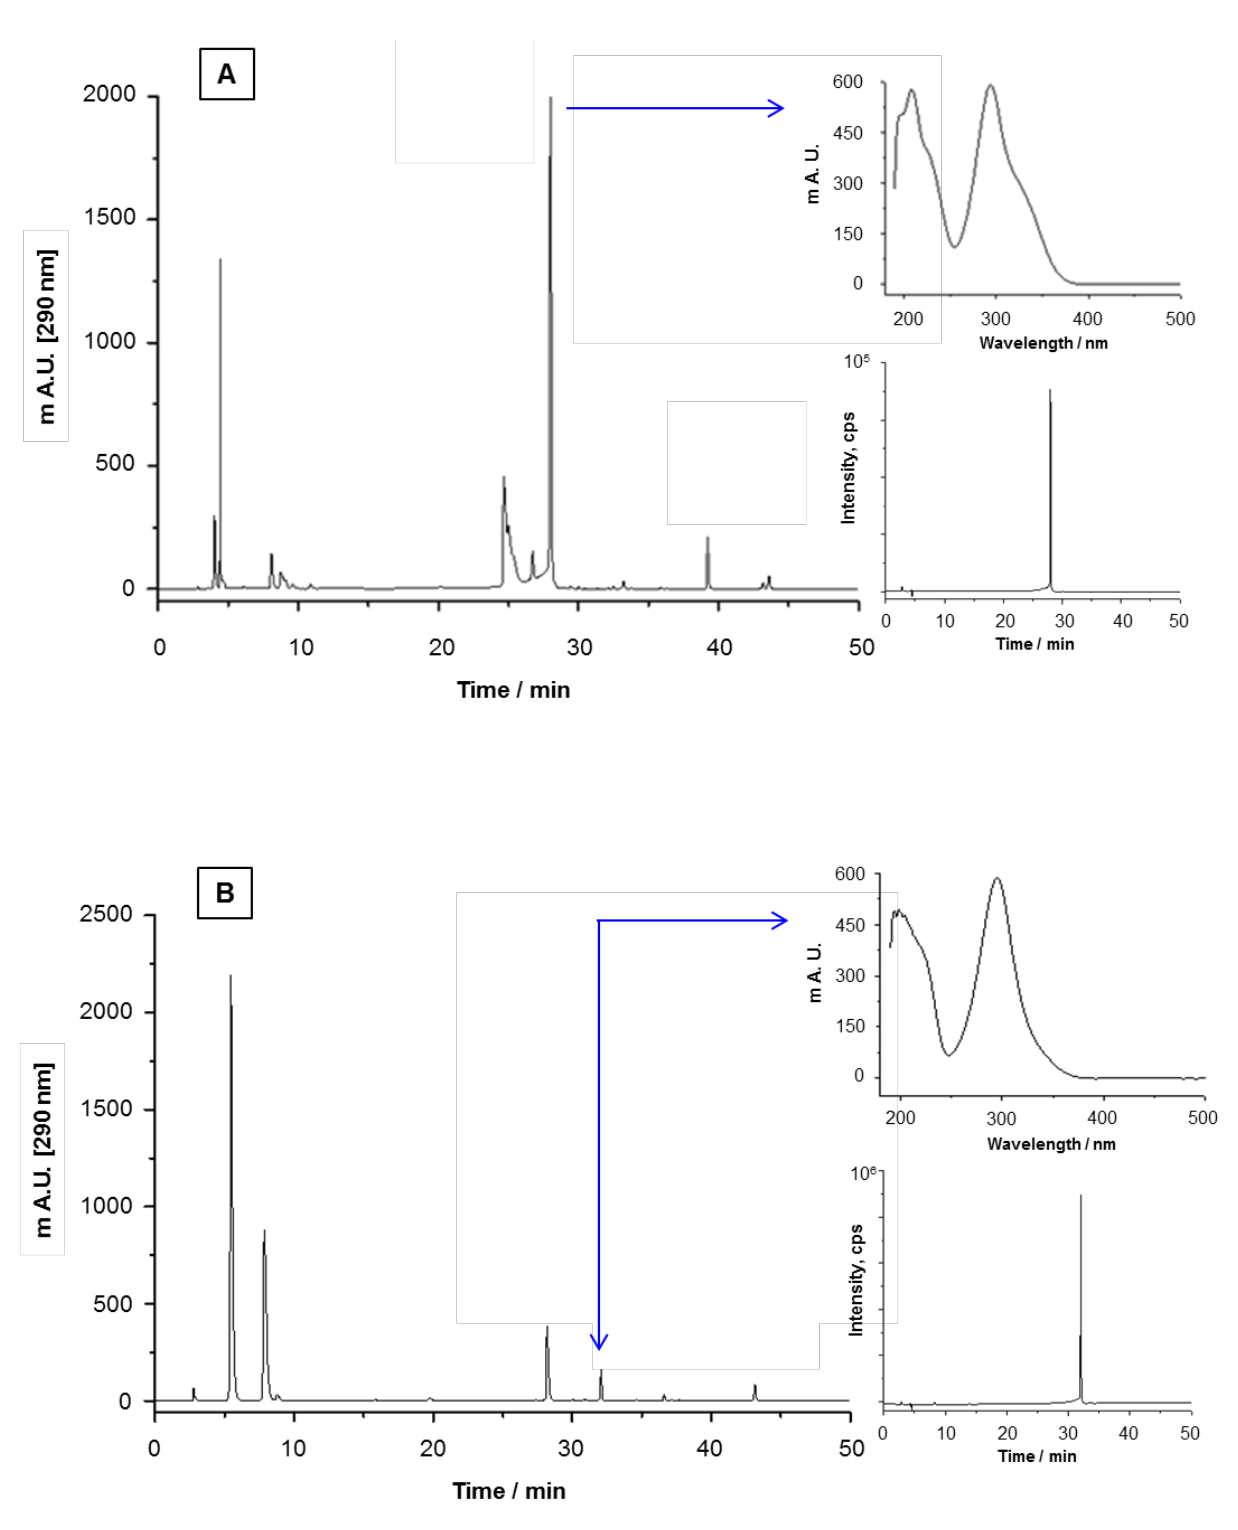
Figure 4. Chromatograms resulting from HPLC-DAD analyses of the oxidation mixtures of the flavonols: ( A ) quercetin and ( B ) kaempferol. In each chromatogram, the peak corresponding to the BZF is indicated with an arrow that connects it with its corresponding UV absorption spectrum. In addition, the UHPLC-ESI-MS/MS chromatograms of the BZF isolated from each oxidation mixture are presented.